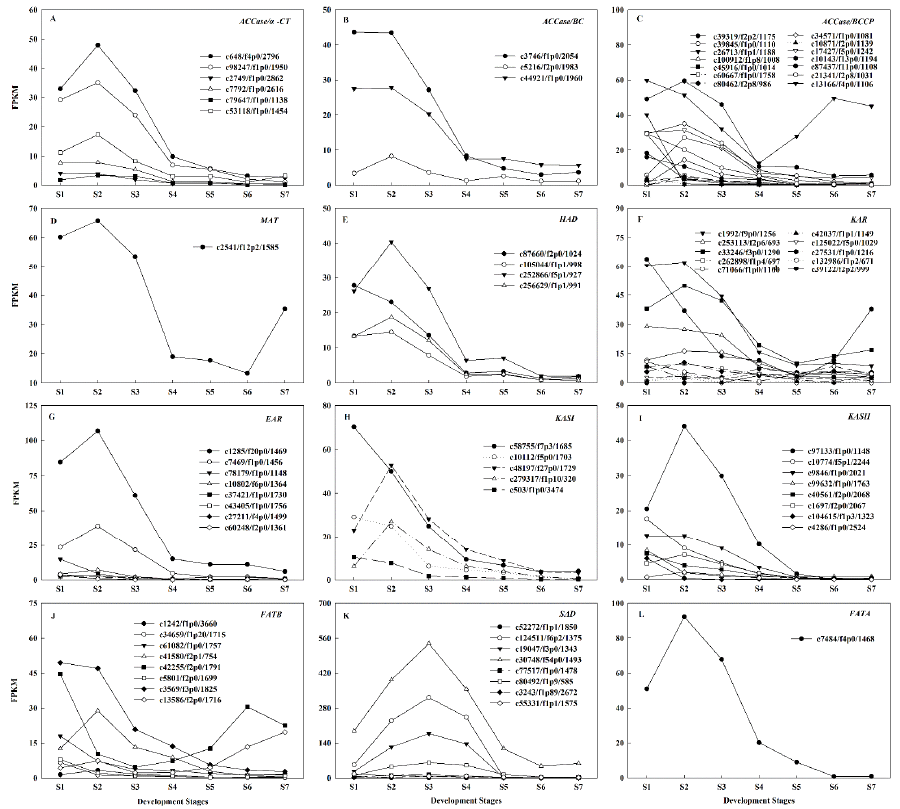
Figure 4. Gene expression analysis of fatty acid (FA) de novo biosynthesis pathway. Gene expression patterns of ACCases / α-CT ( A ), ACCases / BC ( B ), ACCases / BCCP ( C ), MAT ( D ), HAD ( E ), KAR ( F ), EAR ( G ), KASI ( H ) , KASII ( I ), FATB ( J ), SAD ( K ), and FATA ( L ) in developing A. sphaerocephala seeds.